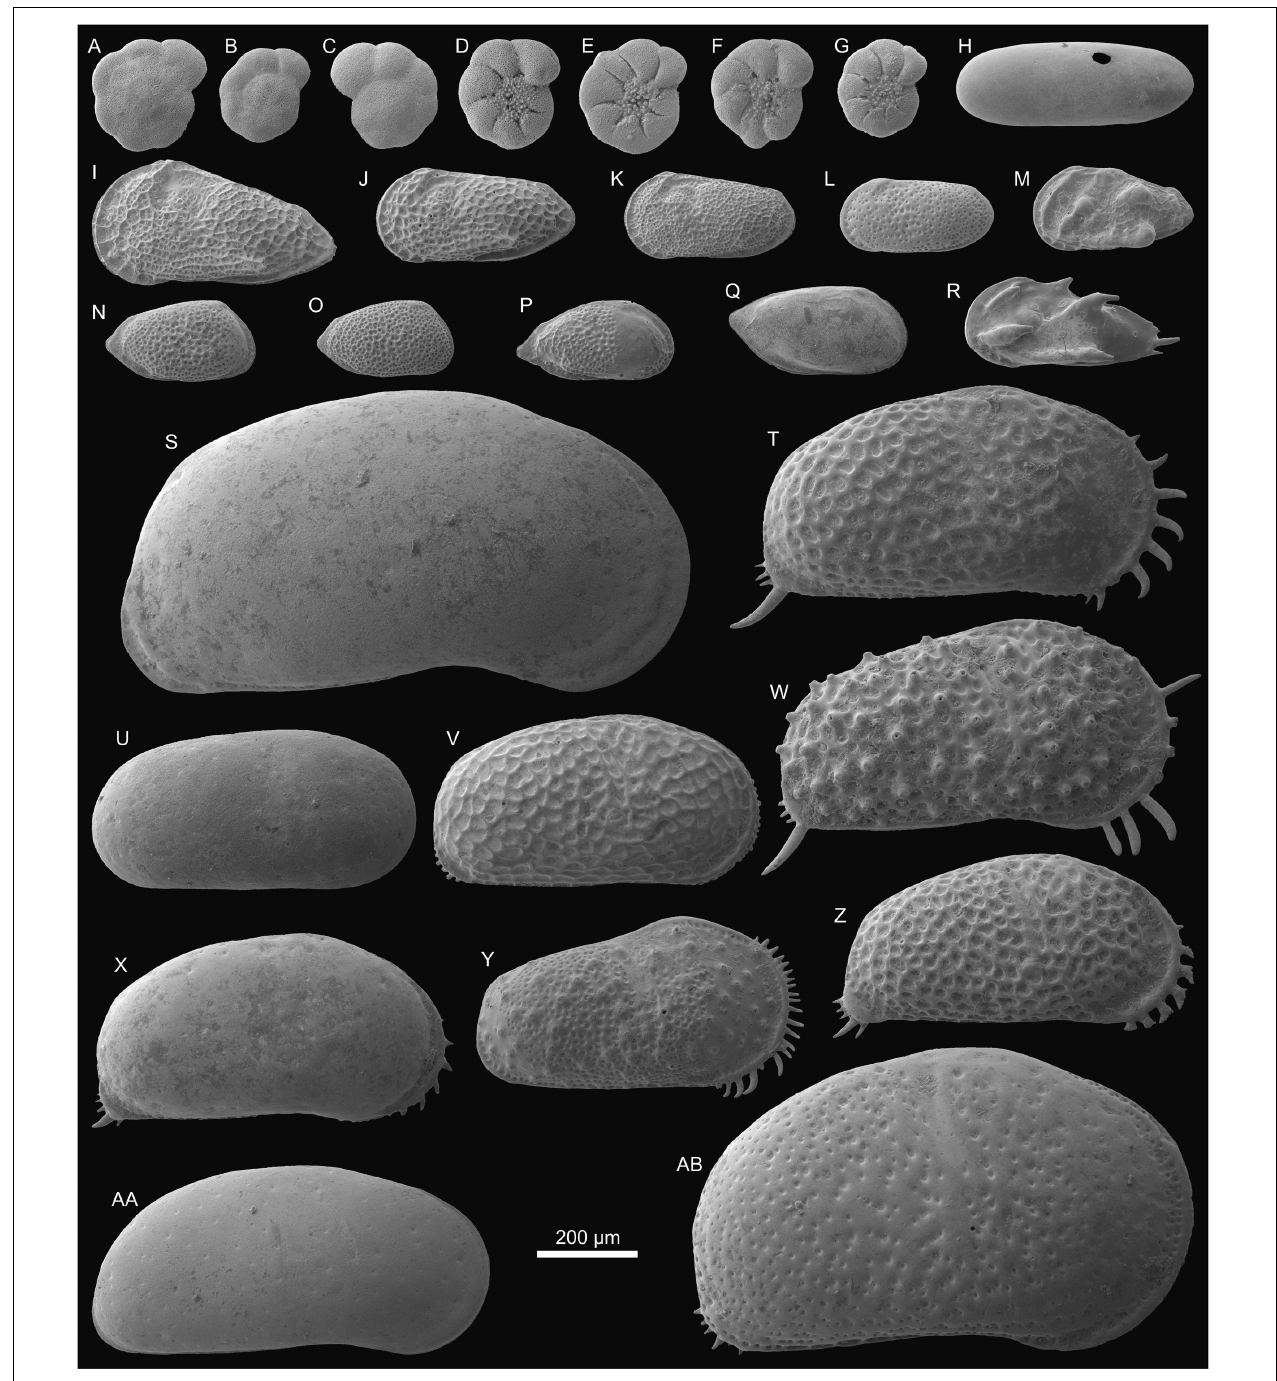
FIGURE 3 | Foraminifers and ostracods from Porvenir (sample PO-N-8). (A–C) Ammonia sp., (A) Tsp (0.25), (B) Tsp (0.20), and (C) Tsp (0.23). (D–G) E. granosum ?, (D) Tsi (0.22), (E) Tsi (0.23), (F) Tsi (0.22), and (G) Tsi (0.19). (H) Alicenula olivencae (Rje, 0.47/0.17). (I) Perissocytheridea acuminata (L (L e, 0.40/0.19). (K) P. ornellasae (L ♂